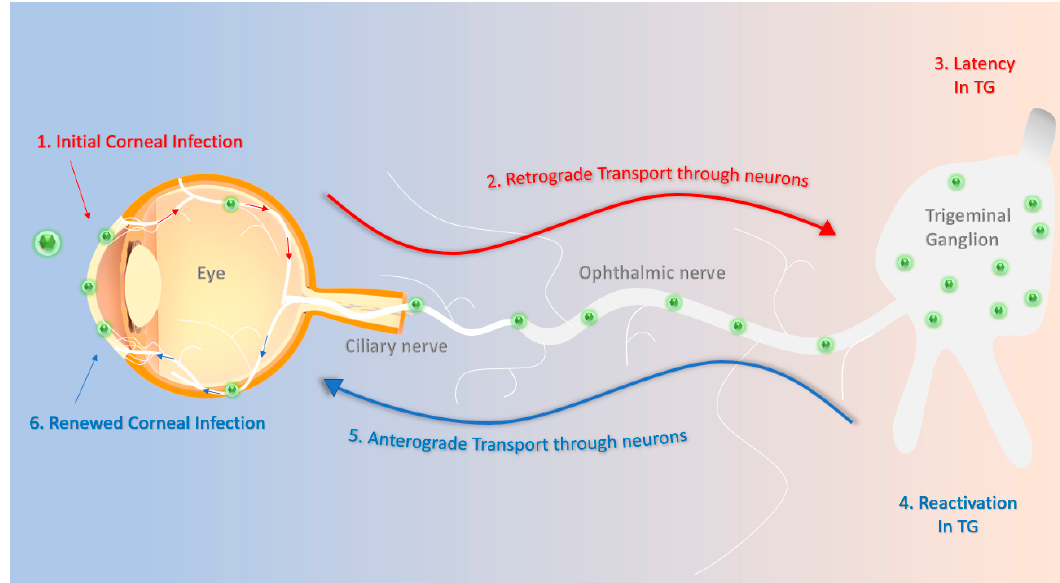
Figure 1. Schematics of herpes simplex virus type-1 (HSV-1) primary and recurrent infection. (1) The HSV-1 virions enter the cornea and initially replicate in the epithelium. (2) They then travel through the ciliary and ophthalmic nerves to the trigeminal ganglion in a retrograde fashion. (3) The virions establish a latent infection that can last for the lifetime of the host. (4) Stress-induced stimuli periodically reactivate the virus. (5) Reactivated virions travel through the ophthalmic and ciliary nerves in an anterograde fashion often to reach back to the site of initial infection. (6) HSV-1 re-infects the cornea, possibly leading to more pathologic symptoms, such as corneal scarring or